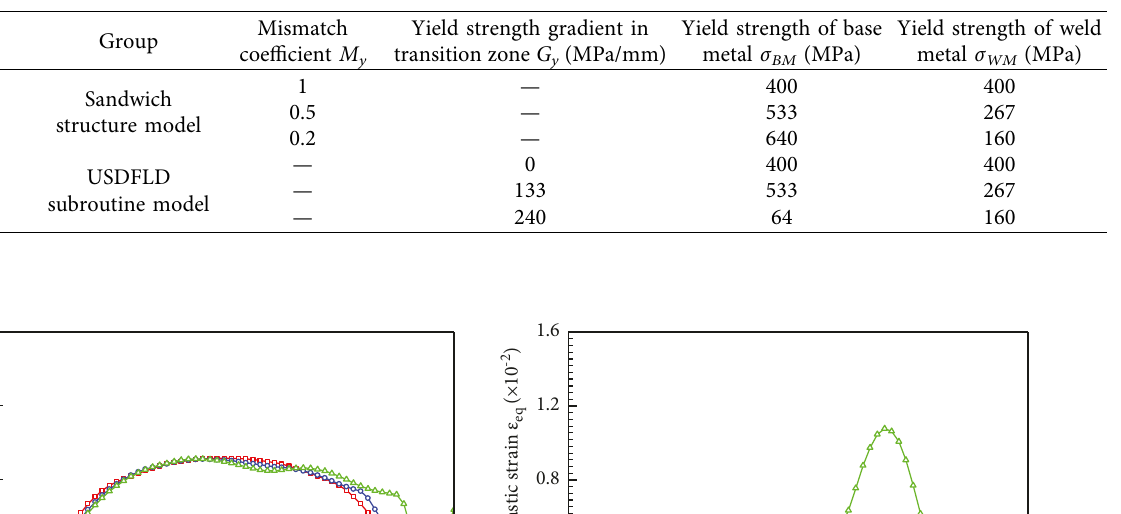
Table 2: Elastic-plastic material property with yield strength changing in the y -direction.